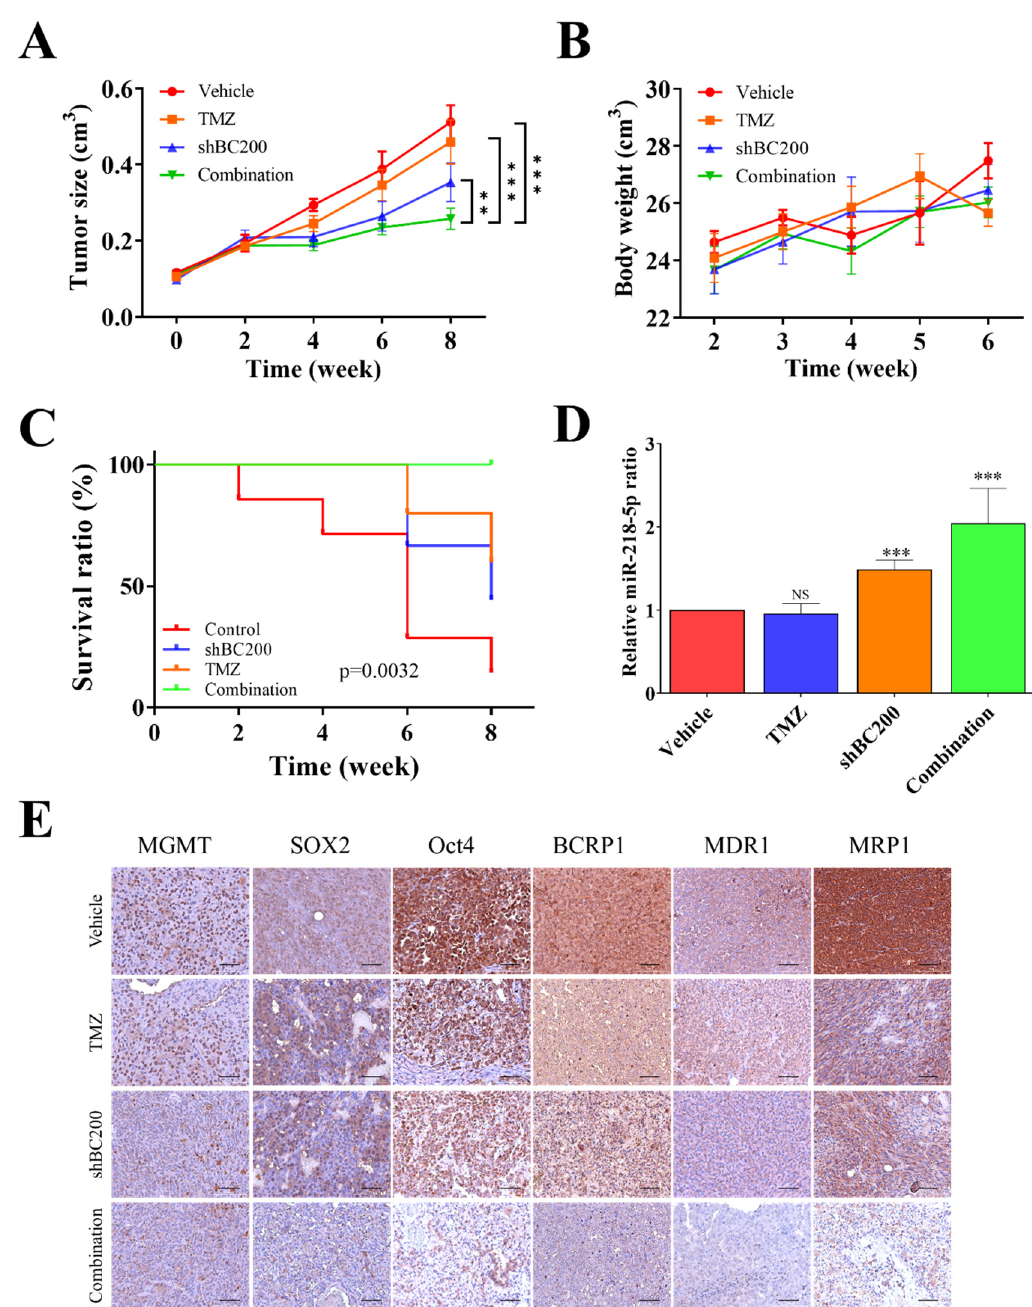
Figure 7. Combination of shBC200 and TMZ inhibits tumor growth in GB mice models. ( A ) Tumor size over time curve indicates that the most significantly delayed tumor growth was observed in the shBC200 and TMZ combination group, followed by shBC200 group, whereas TMZ and control groups did not differ significantly. ( B ) Bodyweight curves over time suggest no clear cytotoxic effects in all mice because no significant decrease in weight was observed. ( C ) Kaplan–Meier survival curve showed increased median overall survival in TMZ, shBC200, and shBC200/TMZ combination, whereas the combination group showed the best survival ratio. ( D ) Comparative real-time PCR analyses showed a significantly increased mRNA level of miR-218-5p expression in both shBC200 and shBC200/TMZ combination groups as compared with vehicle and TMZ counterparts. ( E ) IHC staining showed that treatment in the shBC200 group and shBC200/TMZ combination group suppressed tumorigenesis and TMZ resistance. ** p < 0.01 and *** p < 0.001.